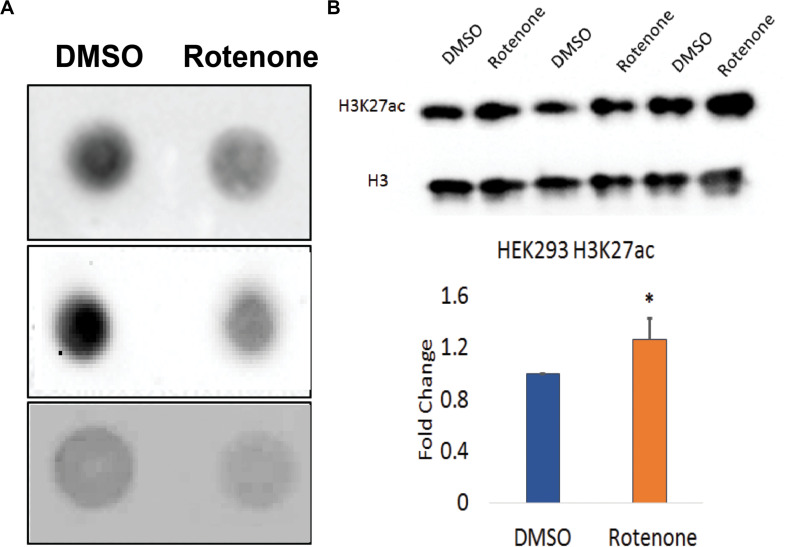
Global epigenetic patterns in rotenone treated HEK293 cells. (A) DNA methylation was visualized by dot blot method using the anti-5mC antibody. Three biological replicates are shown in this image. The standard ladder using 100% 5mC standard is shown in Supplementary Figure 1. (B) Global histone H3K27ac levels were measured from total extracted histones using Western blot. Total histone H3 was used as the loading control. Three biological replicates are shown in this image. This western blot was quantified using ImageJ software and is shown as the fold change in the amount of H3K27ac relative to the vehicle (DMSO) control. ∗p < 0.05 using a paired Student’s t-test with the ratio of H3K27ac/H3.